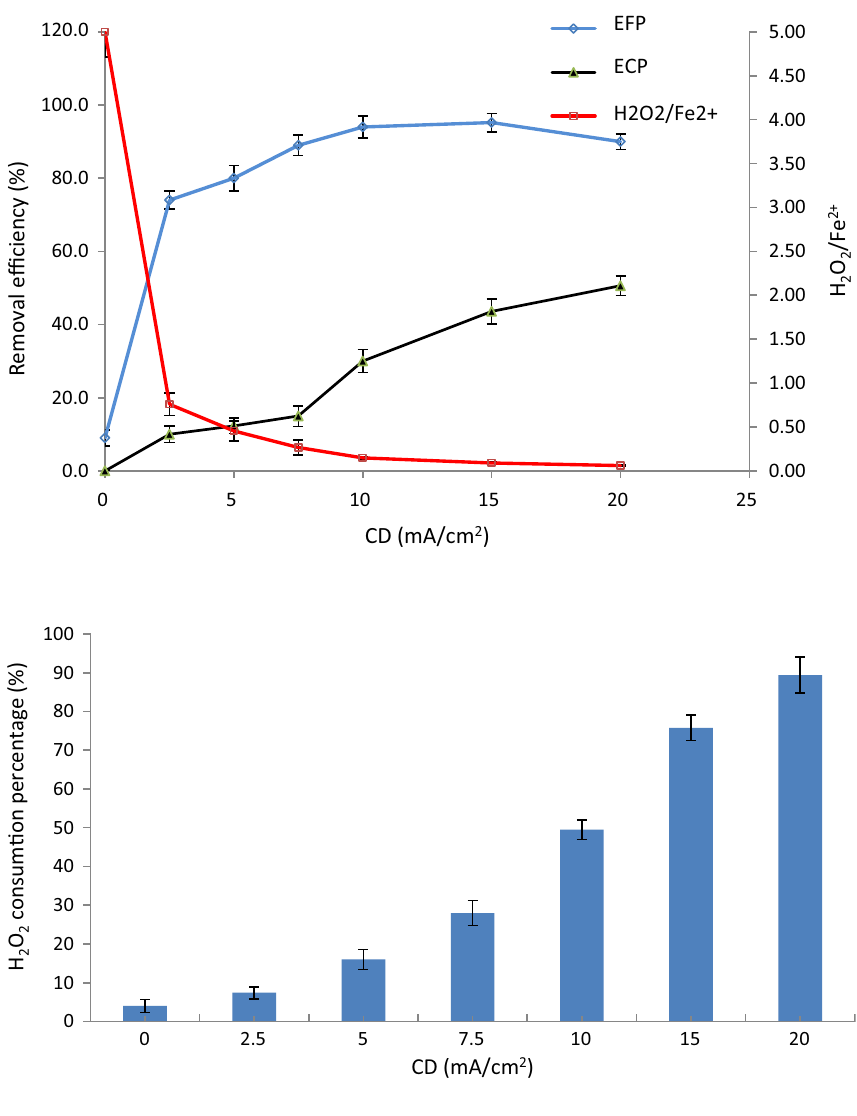
Fig. 4 Effect of current density on MG degradation in EFP and ECP (initial MG concentration = 200 mg/L; solution pH = inherent (3); H 2 O 2 dosage = 50 mg/L; reaction time = 10 min)